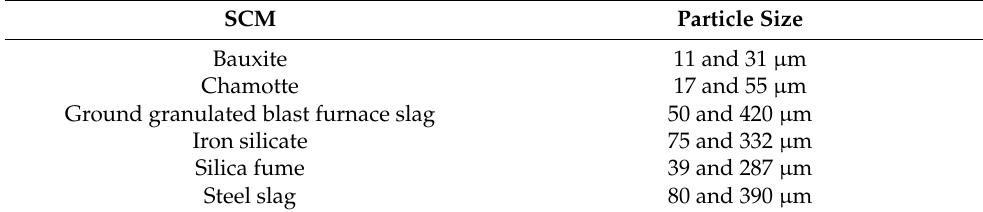
Table 5. Particle size of